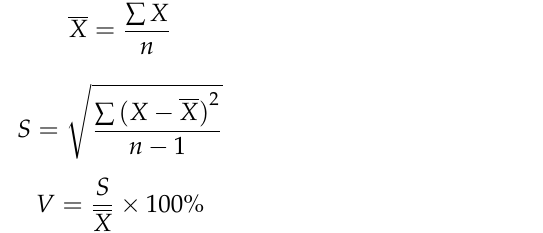
Figure 4. Physical drawing of test bench. According to NY/T 1003-2006 “Technical specification for quality evaluation of fertilizer application machinery”, the coefficient of variation of the consistency of fertilizer discharge volume in each row of the distribution system was determined. The number of test rows is not less than 6 rows, and the standard deviation S and the coefficient of variation V are calculated for the consistency of fertilizer discharge between rows.